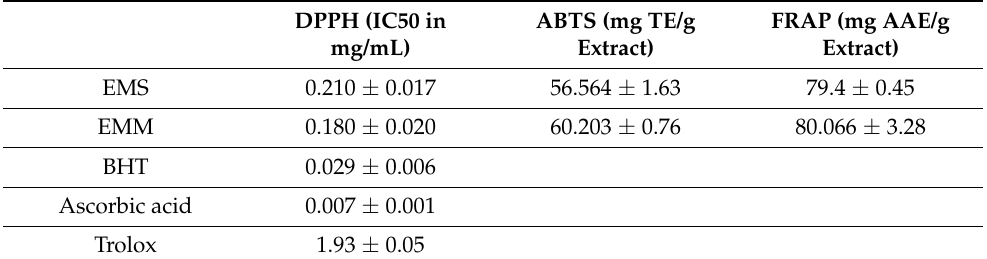
Table 3. Antioxidant activity of B. hispanica by DPPH, FRAP, and ABTS. DPPH (IC50 in